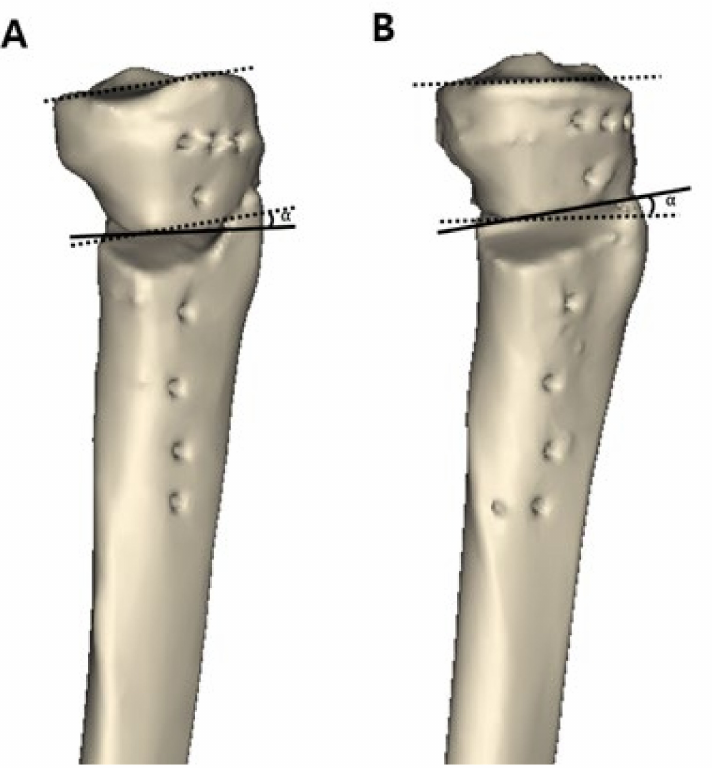
Figure 1. The patients were divided into two groups according to the osteotomy inclination angle in the sagittal plane in a three-dimensional reconstructed model. On the true lateral view, a black dotted line was drawn as a medial tibial plateau line. A black solid line was drawn as a sagittal osteotomy line on the anteromedial aspect of the lowermost part of the proximal tibial segment. The angle ( α ◦ ) formed by these two lines was defined as the osteotomy inclination angle. ( A ) group A, the osteotomy line is inclined anteriorly with respect to the medial tibial plateau line. ( B ) group P, the osteotomy line is inclined posteriorly with respect to the medial tibial plateau